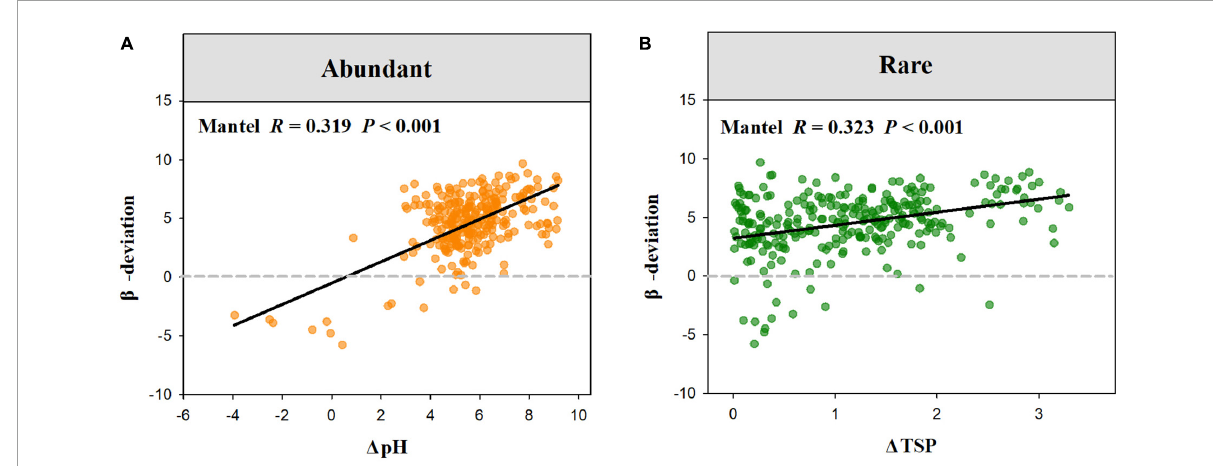
FIGURE5 The relationships between abundant (A) and rare (B) fungal β -deviation and difference in pH and TSP.